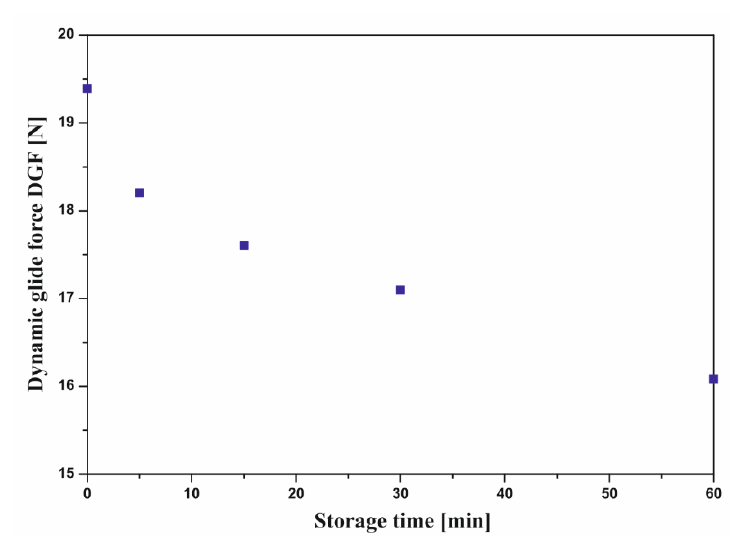
Figure 6. E ff ect of storage time at room temperature on injectability of chitosan Figure 6. Effect of storage time at room temperature on injectability of chitosan sol.